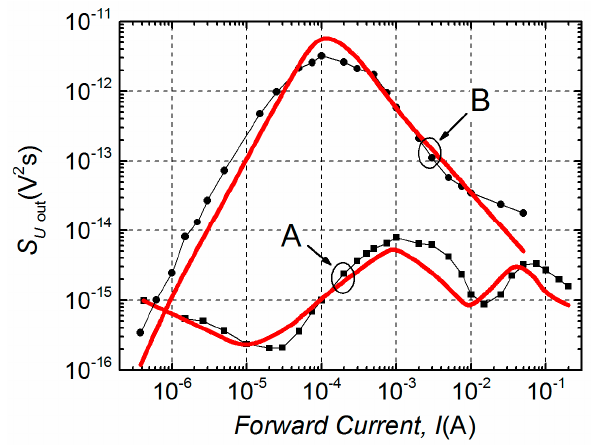
Figure 10. Comparison of the experimental voltage fluctuation spectral density dependencies on forward current at 1 kHz frequency (black curves with symbols) and the calculated data (red curves) for LDs of groups A and B at RT.